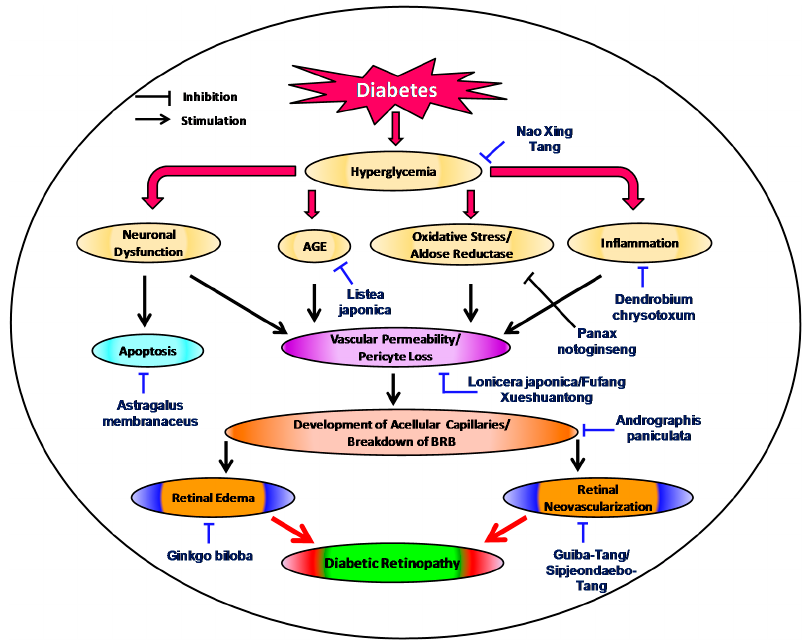
Figure 1. Proposed schematic presentation of the signaling pathways in the